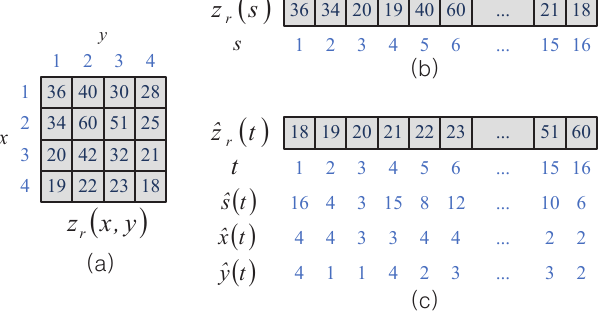
Figure 5. The proposed WP initial weight setting method. ( a ) z r ( x , y ) is a reference depth map estimated by Sum-Modified-Laplacian (SML) or Gray-Level-Variance (GLV); ( b ) z r ( s ) is 1-dimensional vector form of the z r ( x , y ) and s is the index of z r ( s ) ; ( c ) ˆ z r ( t ) is the sorted reference depth map into depth order, t is the index of ˆ z r ( t ) , ˆ s ( t ) is the index of z r ( s ) corresponding to the depth of ˆ z r ( t ) , and ( ˆ x ( t ) , ˆ y ( t )) is the index of z r ( x , y ) corresponding to the depth of ˆ z r ( t )